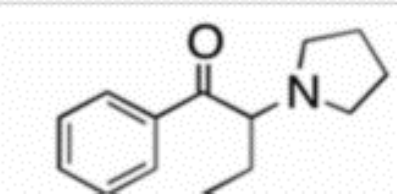
Figure 7. Represents the chemical structure of PVP [56].